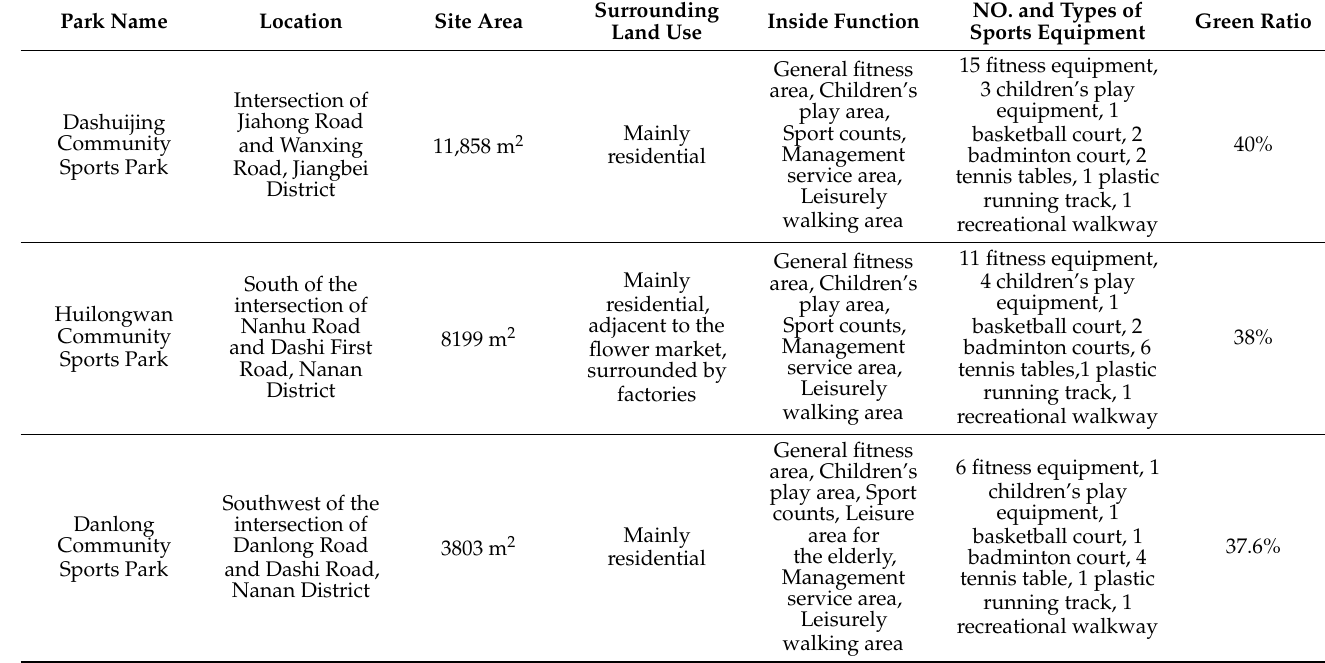
Table 1. Basic overview of the three community sports